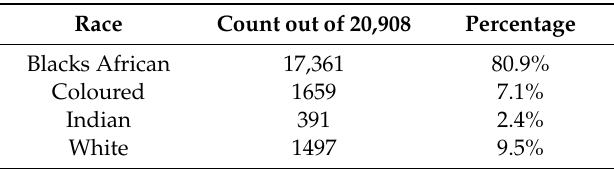
Table 2. Study of population distribution.